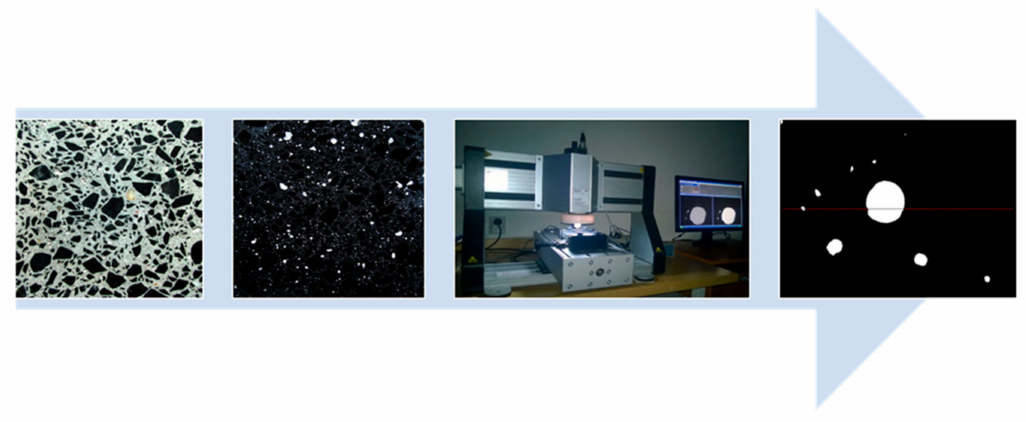
Figure 2. The air void parameter (AVP) determination